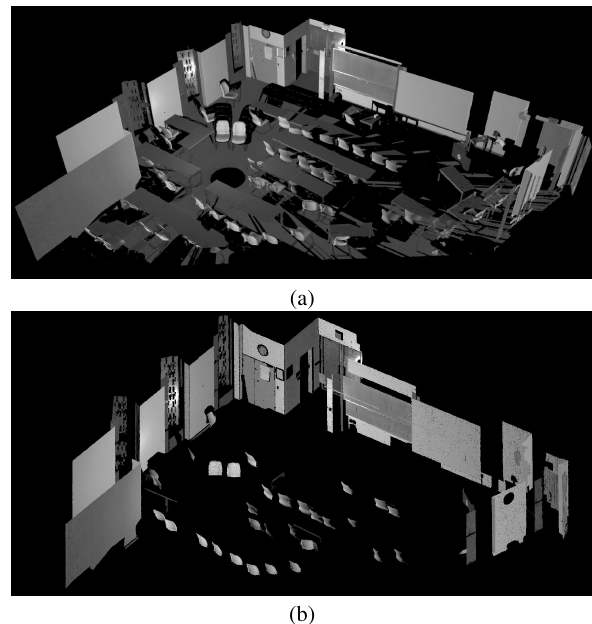
Figure 2: Point cloud of a classroom. (a) Original scene. (b) Vertical planes only.